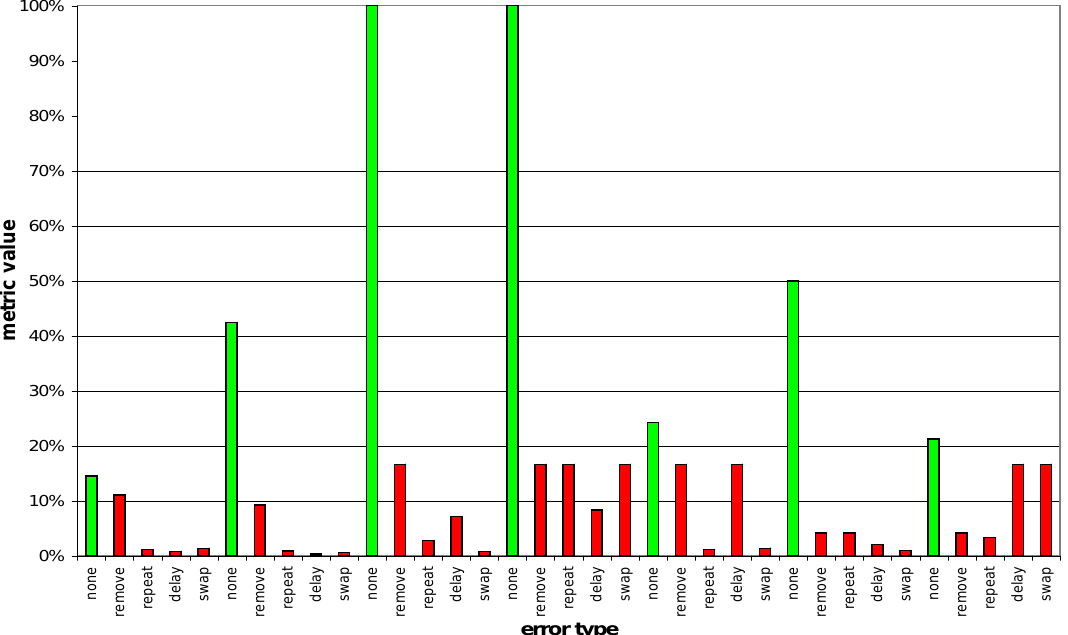
Figure 11. Metric values of P1 after 21 days (green: normal behavior; red: abnormal